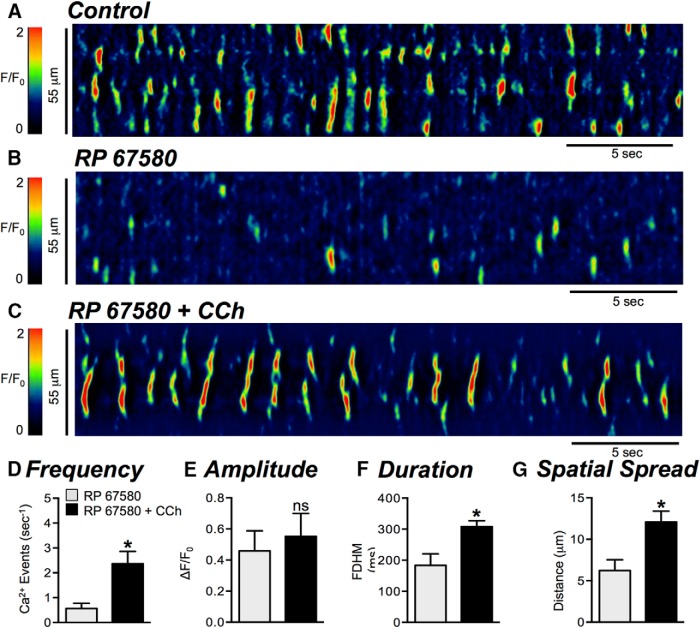
NK1 antagonist does not interfere with Ca2+ release mechanisms. A, B, Representative ST maps showing the effect of the NK1 antagonist RP 67580 (1 μM) on Ca2+ transients in ICC-DMP. C, ST map showing that in the presence of RP 67580, CCh (10 μM) strongly activates Ca2+ transients. D–G, Summary graphs showing the effects of CCh on Ca2+ transient parameters: frequency (D), amplitude (E), duration (F), and spatial spread (G) in ICC-DMP in the presence of RP 67580 (n = 3, c = 6); *p < 0.05.